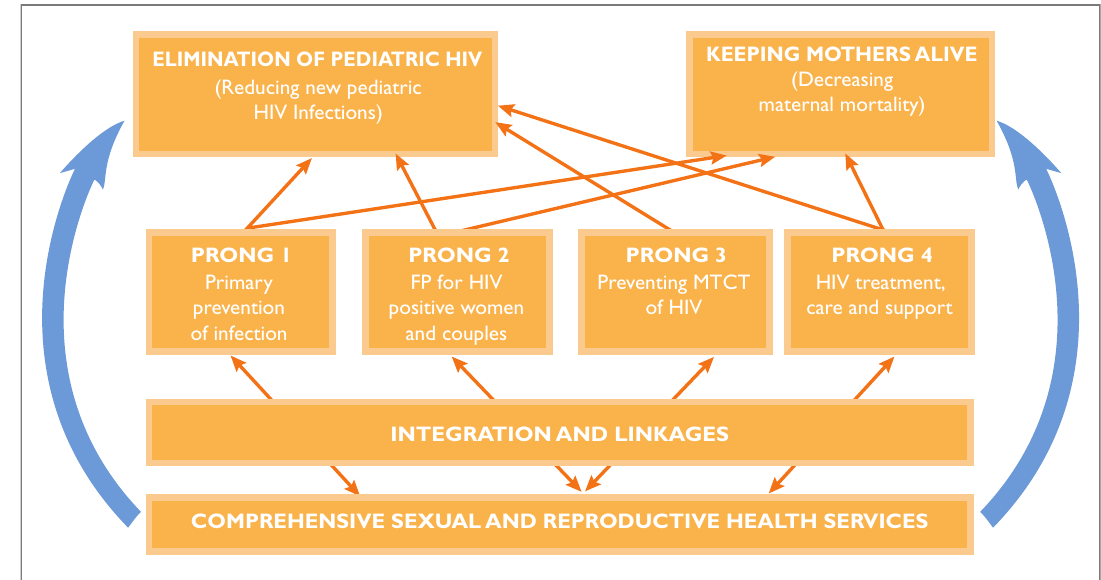
Figure 2. PMTCT Prongs and Integration and Linkages to SRH Services’ Contribution to the Elimination of Pediatric HIV and Keeping Mothers